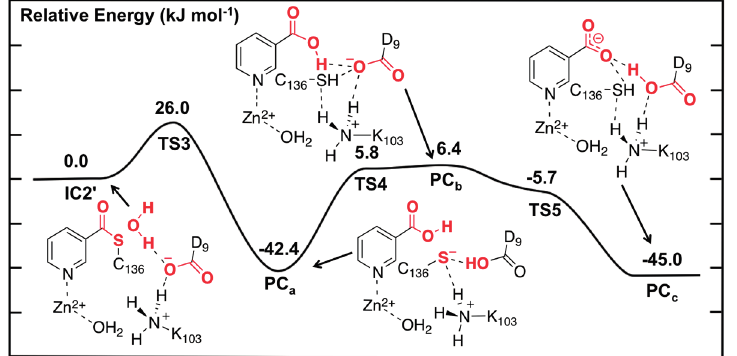
Figure 5. Potential energy surface (kJ·mol − 1 ) obtained at the ONIOM(B3LYP/6- 311+G(2df,p):AMBER96)-EE//ONIOM(B3LYP/6-31G(d):AMBER96)-ME level of theory for the hydrolysis of the thioester intermediate and product complex